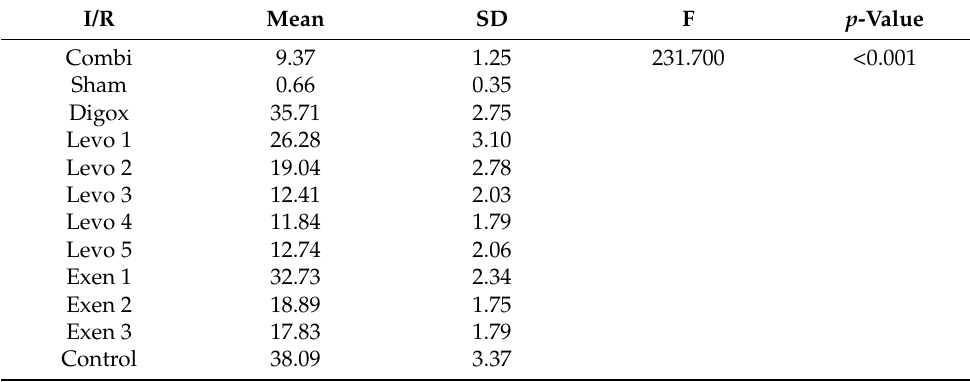
Table 16. Effect of group on